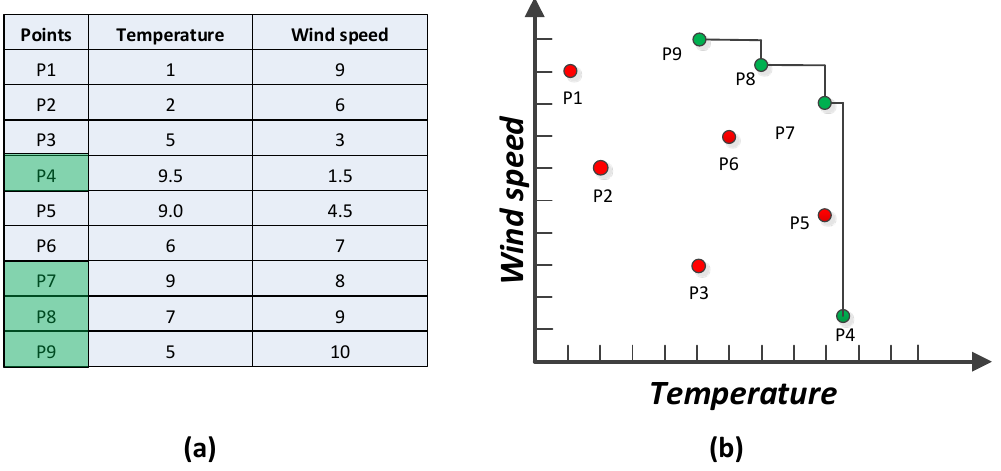
Figure 2. ( a ) Skyline of sensor readings, ( b ) Representation of sensor readings in 2D space [11].